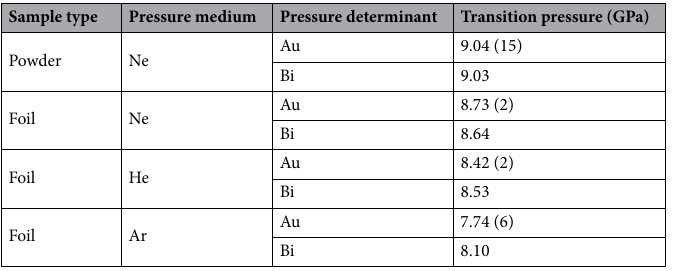
Table 1. Bi-III/Bi-V transition pressures for samples compressed in a range of different pressure-transmitting media.